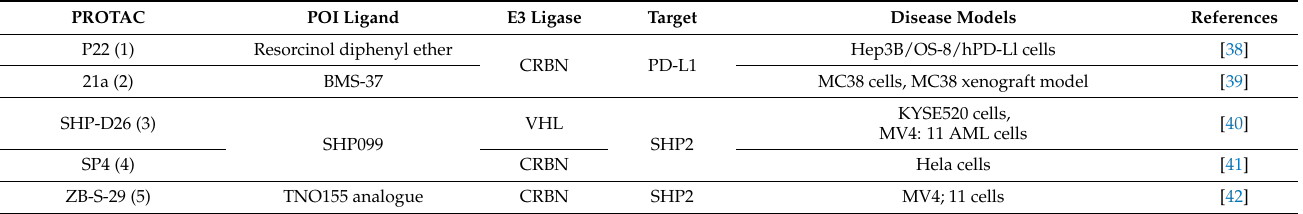
Table 1. The summary and comparison of small-molecule PROTACs for tumor